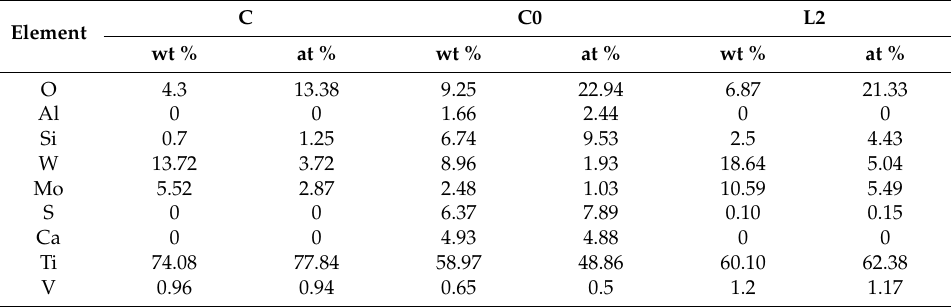
Table 4. Statistical table of the weight percentage of catalyst